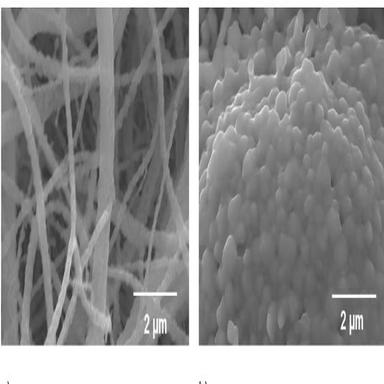
SEM micrographs (SE-mode) of the 3Y–Zr fibers sintered with a heating rate of 1 K/min a) 1100 °C and b) 1350 °C.